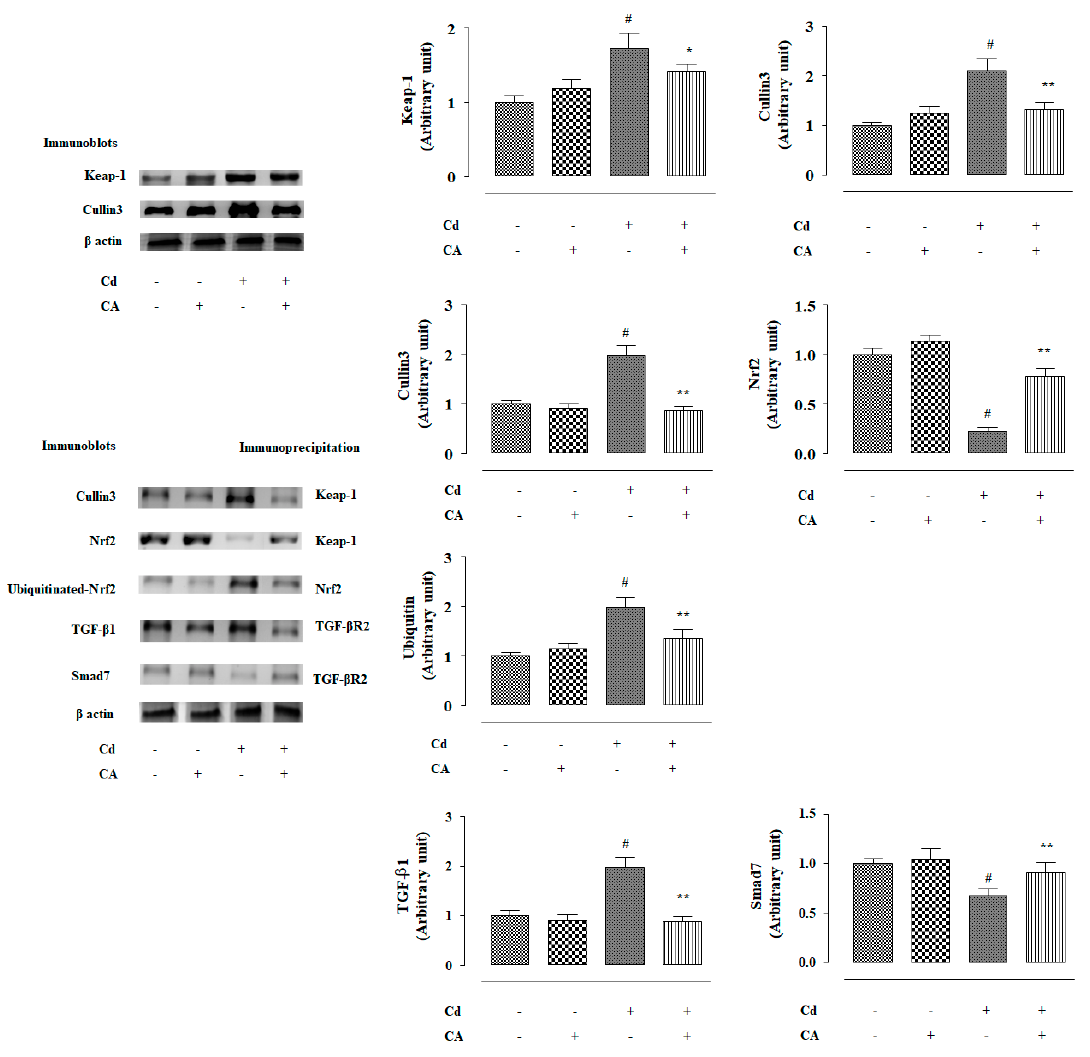
Figure 7. The effects of CdCl 2 and/or CA on co-immunoprecipitation assays in mouse kidneys in vivo. The relative band intensities were measured and the intensity of the normal control band was chosen as 1. β -actin served as loading control. Data are represented as mean ± SD, n = 6. # Values significantly ( p < 0.01) differed from the vehicle-treated group. * Values significantly ( p < 0.05) differed from only the CdCl 2 -treated group. ** Values significantly ( p < 0.01) differed from only the CdCl 2 -treated group.